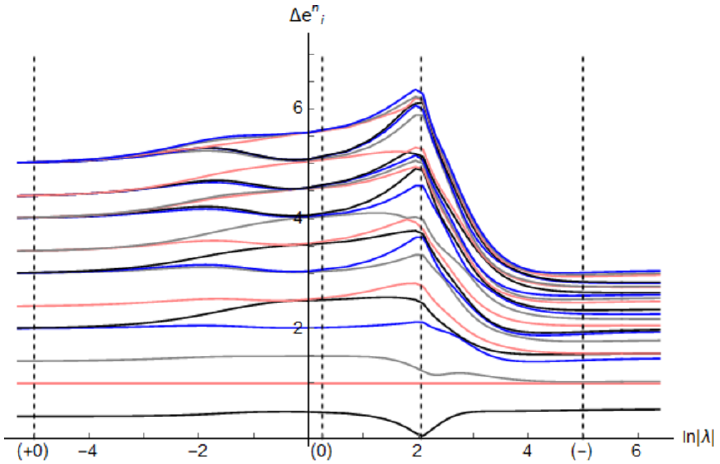
Figure 21. Normalised Energies (w.r.t. E 2 ) in the perturbed TIM with ( d ) spectator for negative coupling. Respective truncation levels N (cid:27) = 20, N (cid:27) 0 =